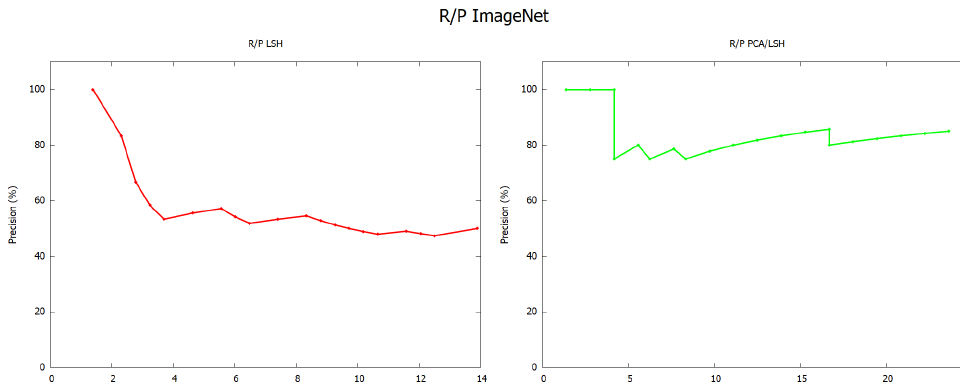
Figure 6. Recall/precision within ImageNet